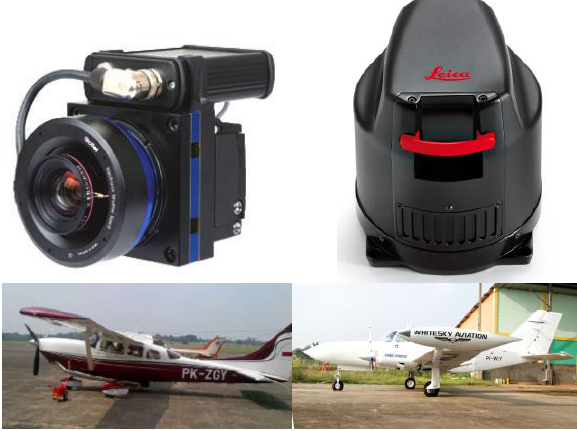
Figure 4. Aircraft and cameras used (left : Cessna 206t with Trimble P65+, right : Cessna 402b with Leica